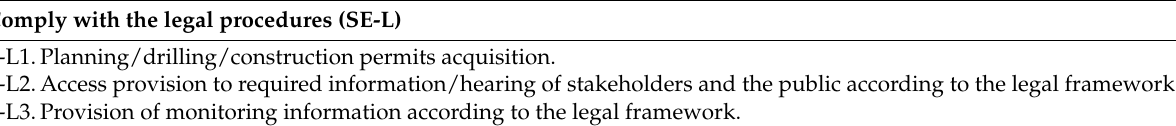
Table 2. Social engagement strategy options (based on [14]).